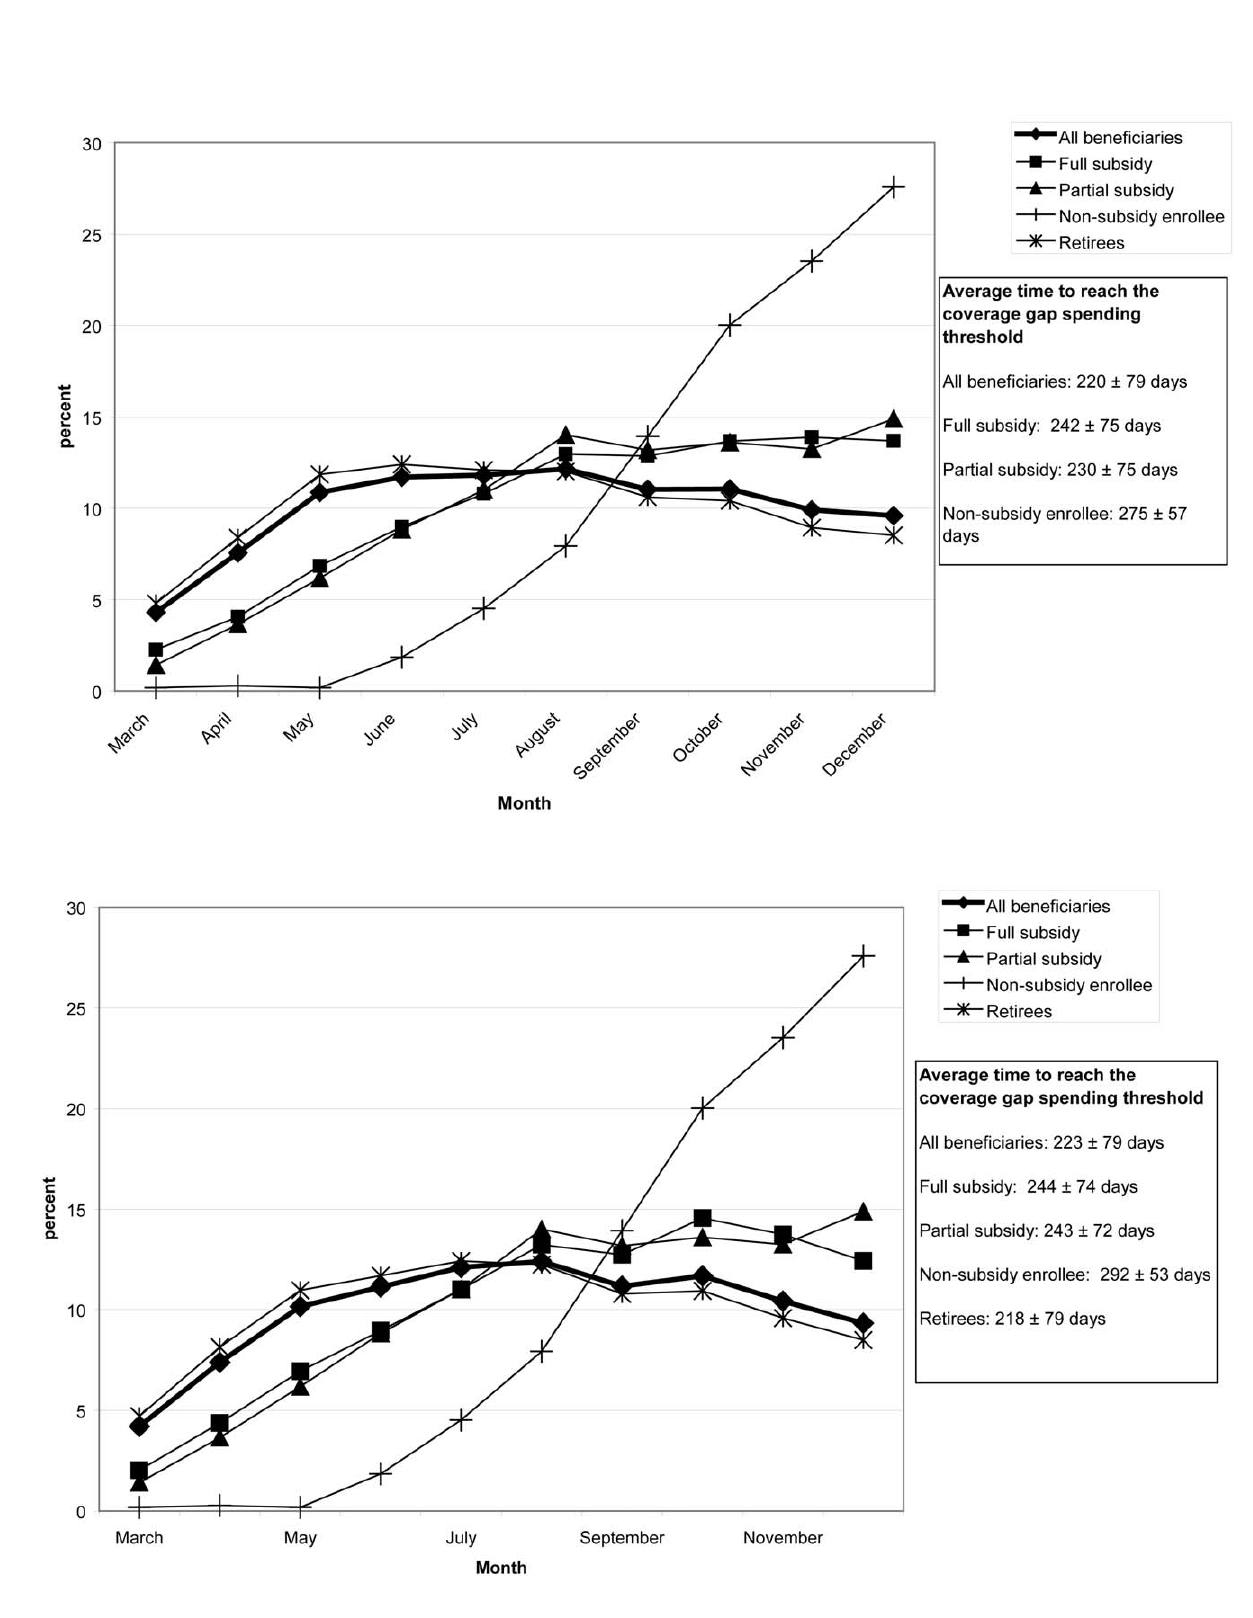
Figure 2. (A) Proportion of beneficiaries reaching the coverage gap spending threshold in each month in 2006, by beneficiary group. (B) Proportion of beneficiaries who reach the coverage gap spending threshold in each month in 2007, by beneficiary group. doi:10.1371/journal.pmed.1001075.g002 PLoS Medicine |